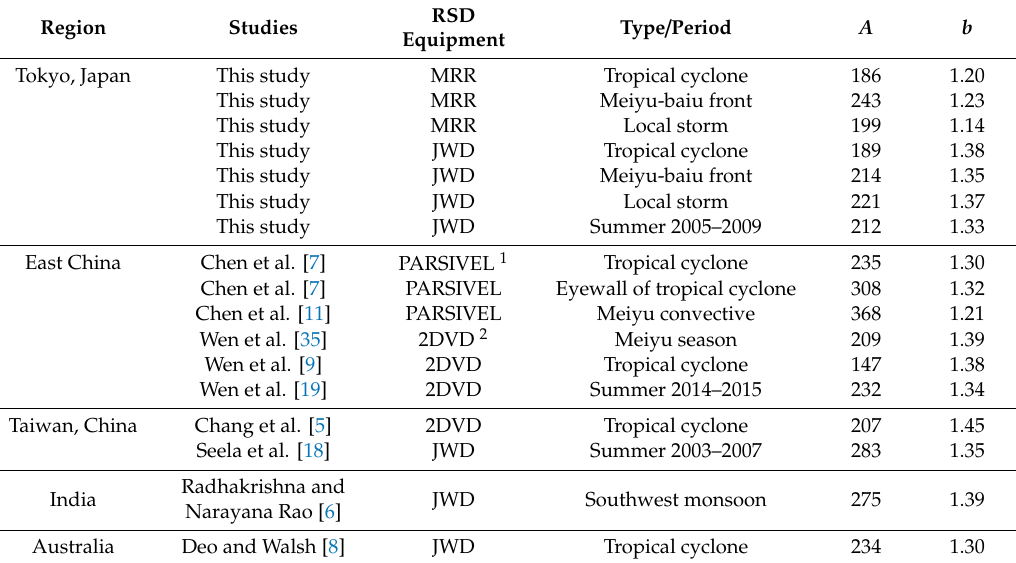
Table 4. Z – R relationship ( Z = AR b ) coe ffi cient ( A ) and power ( b ) in di ff erent regions.